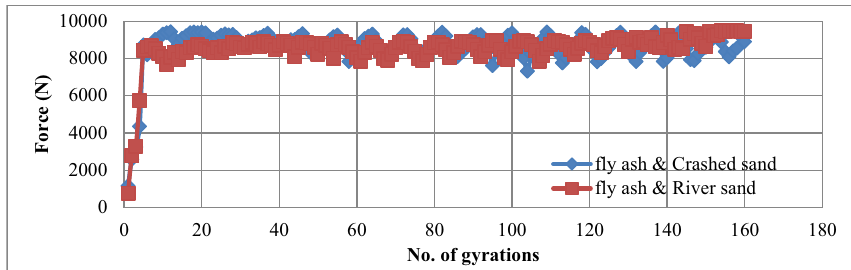
Figure 7: The measured force on the sample obtained from the modi fi ed gyratory apparatus using fl y ash as fi